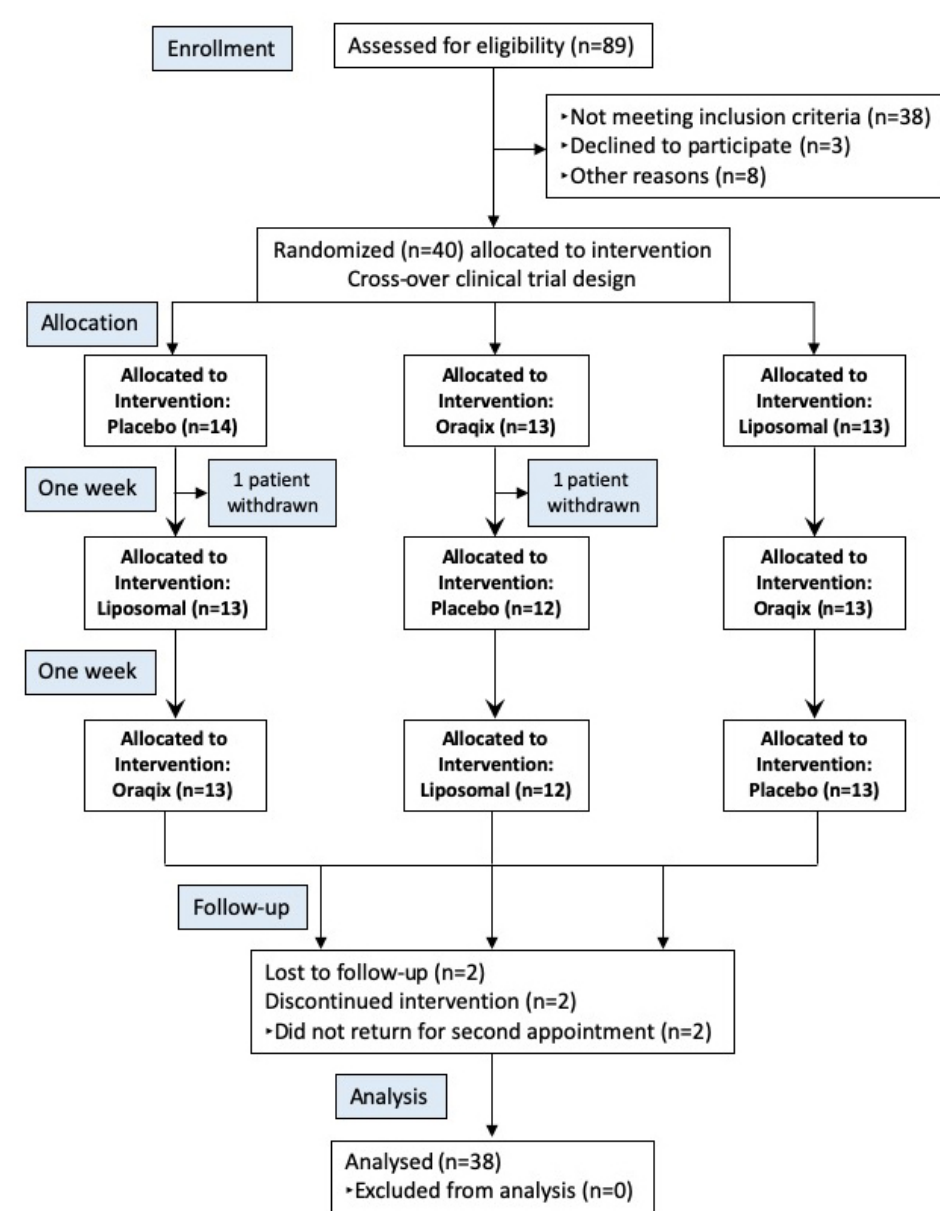
Figure 1- Flowchart of subjects throughout the stages of the study. At the end of the clinical trial, all untreated sextants received periodontal